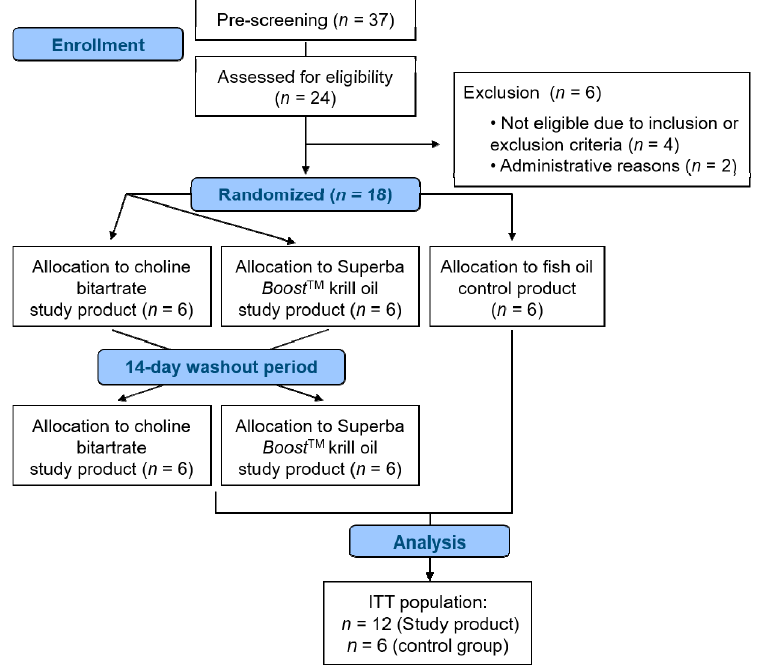
Figure 1. Flow chart of subject recruitment and included study subjects. ITT: intention-to-treat.